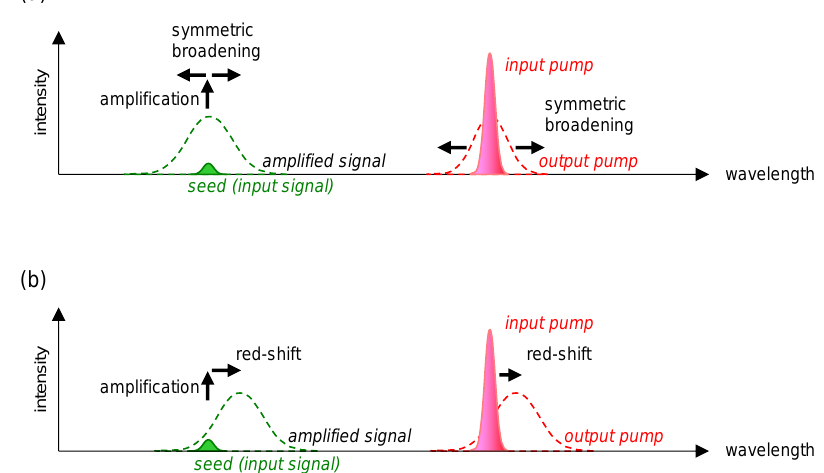
Figure 1. The schematic drawing of the four-wave optical parametric amplification (FWOPA) in ( a ) Raman-inactive and ( b ) Raman-active media. The wavelength of the signal pulse is assumed to be shorter than the wavelength of the pump pulse as in the experimental condition in this